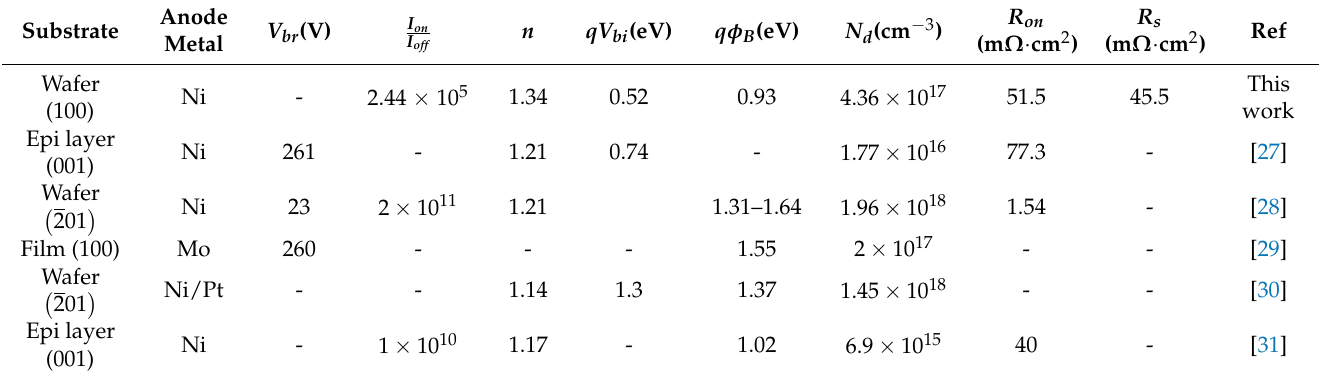
Table 2. Basic performance parameters of some reported Ga 2 O 3 Schottky diodes in 2019 and